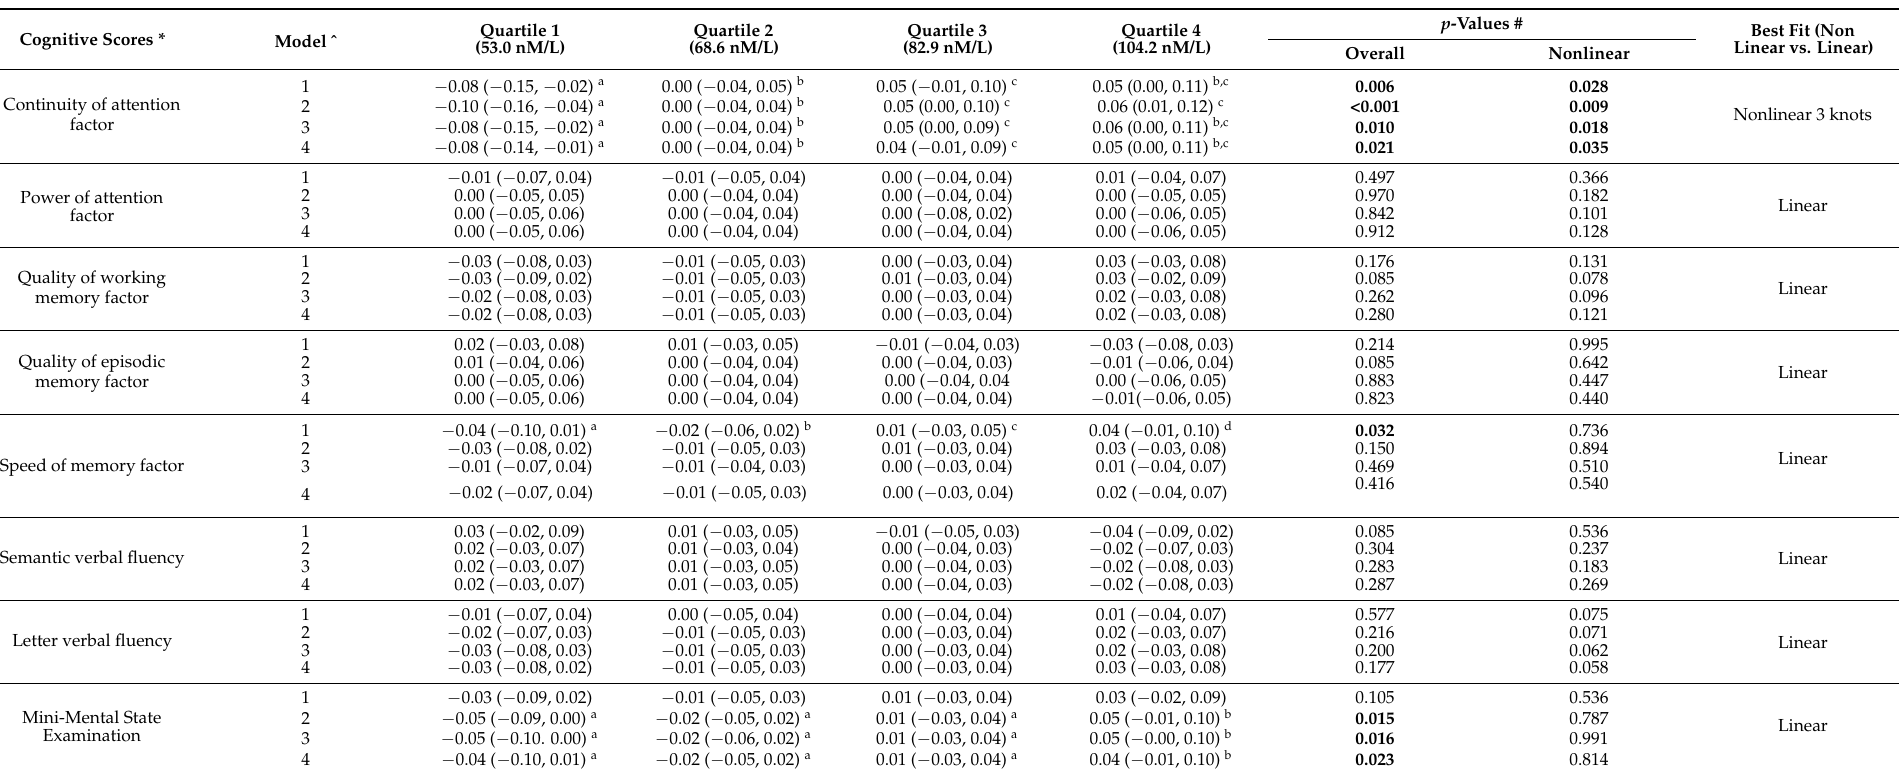
Table 2. Cognitive z -scores (least square means and 95% confidence limits) at mid-quartile levels of serum 25OHD in BHAS women derived from ‘best fit’